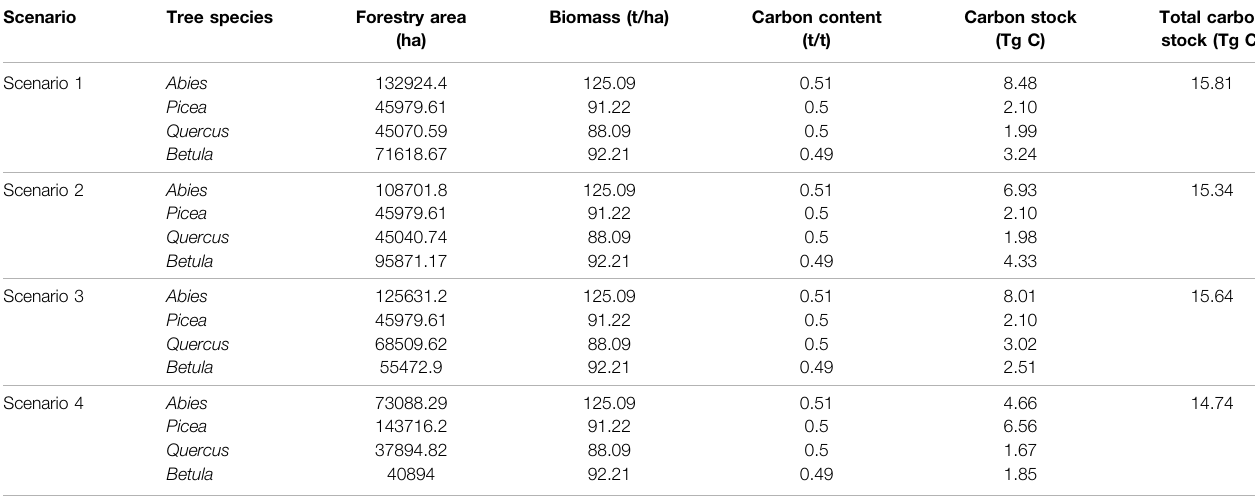
TABLE 4 | Carbon stock of suitable distribution patterns under four